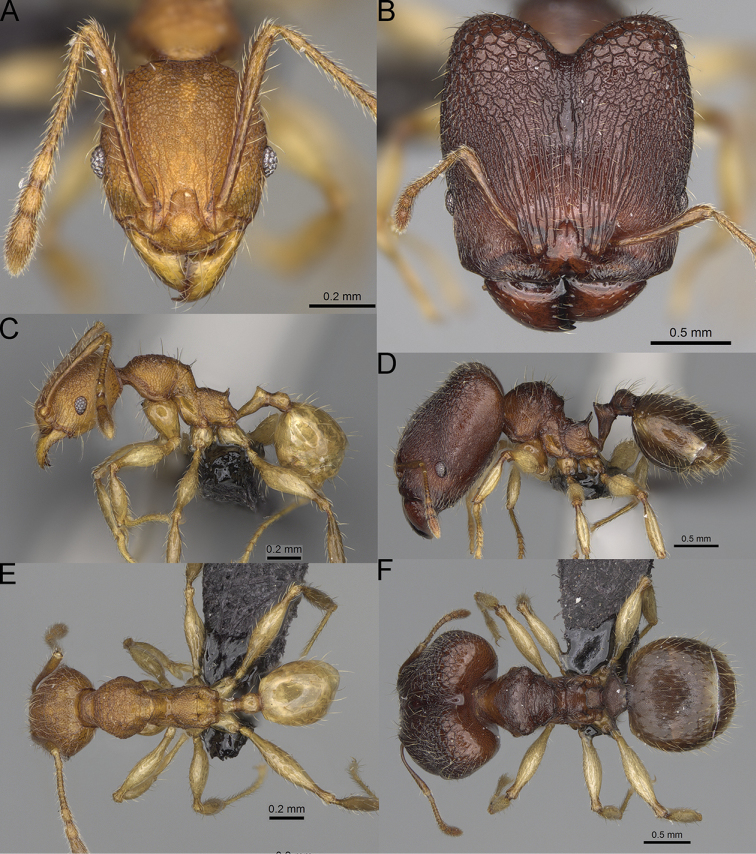
Pheidole
moramanaensis sp. nov., full-face view (A), profile (C), and dorsal view (E) of paratype minor worker (CASENT0923172) and full-face view (B), profile (D), and dorsal view (F) of holotype major worker (CASENT0050486).